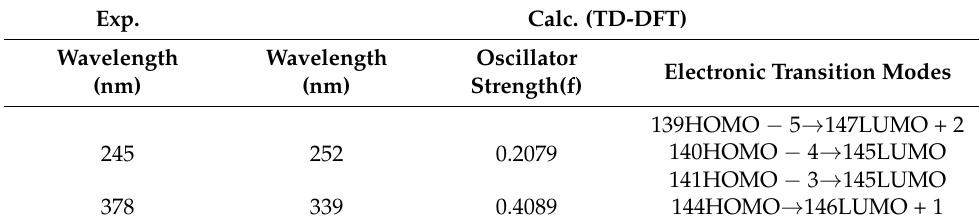
Table 5. Experimental and calculated electronic absorption spectra